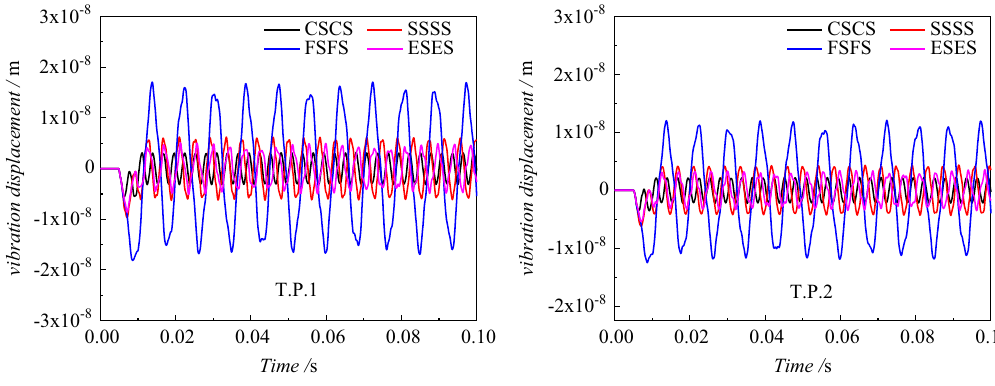
Figure 15: Comparison of the undamped transient vibration with di ff erent boundary